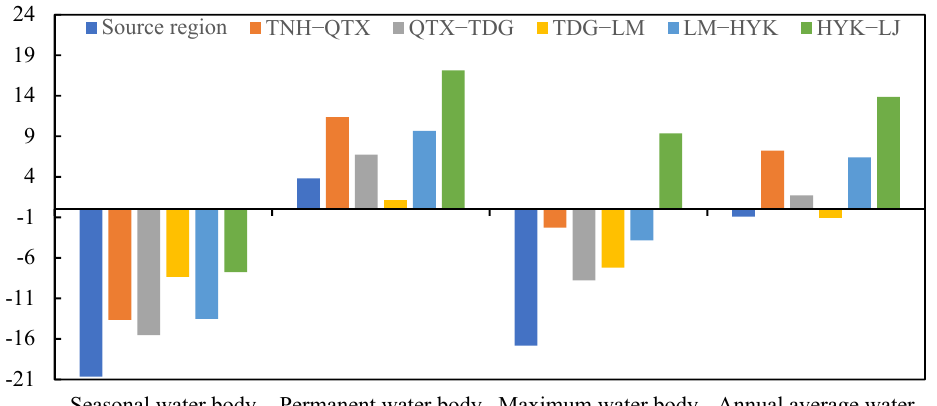
Figure 10. Interannual rates of change for the different types of water bodies in six sub-regions from the upper to the lower reaches in the YRB during 1986–2019.